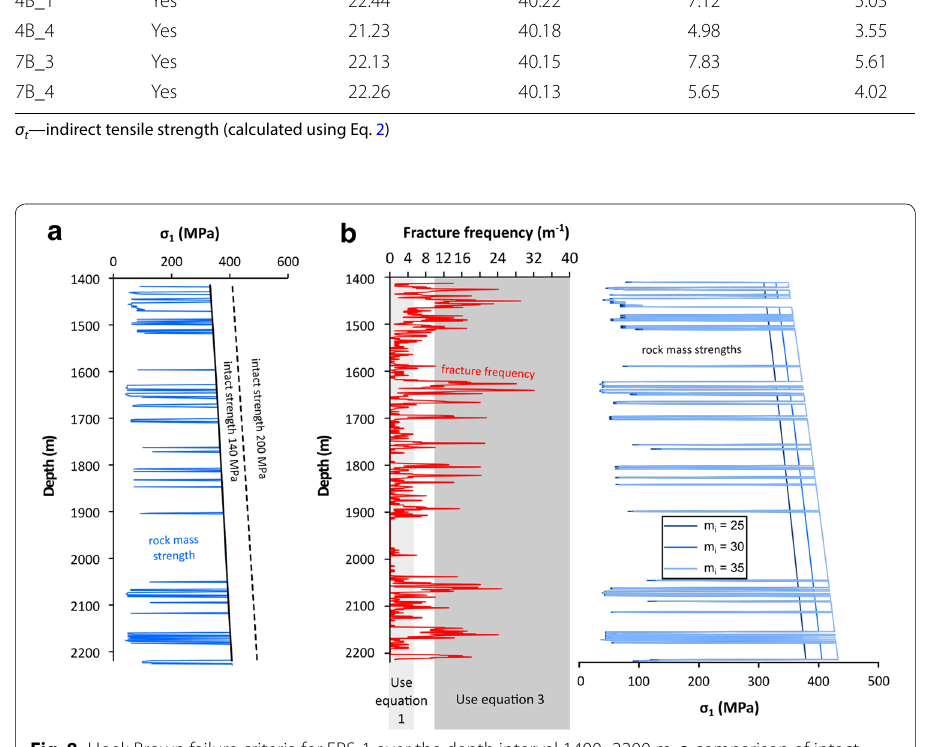
Fig. 8 Hoek Brown failure criteria for EPS-1 over the depth interval 1400–2200 m; a comparison of intact strength (using Eq. 1 for C o 140 MPa (solid line) and 200 MPa (dashed line) and m i 30, see text for details) = = and rock mass strength (using Eq. 3) for C o 140 MPa and m i 30; b comparison of fracture density and = = resulting rock mass strength for C o 140 MPa and three different m i values (25, 30, and =